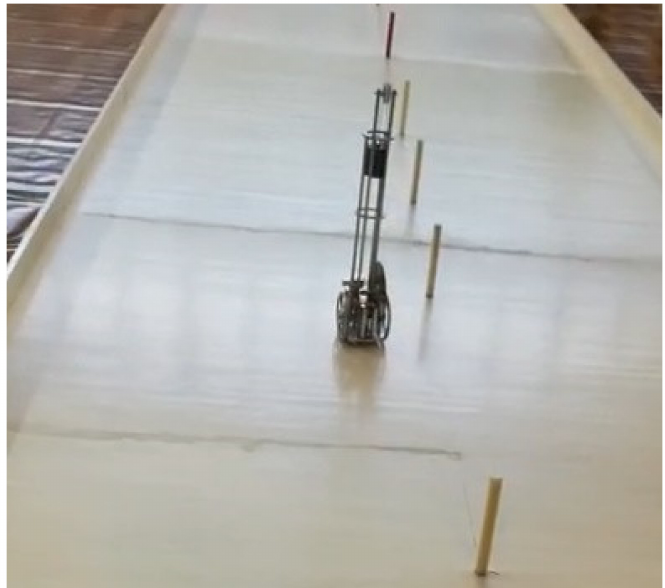
Figure 14. Obstacle avoidance